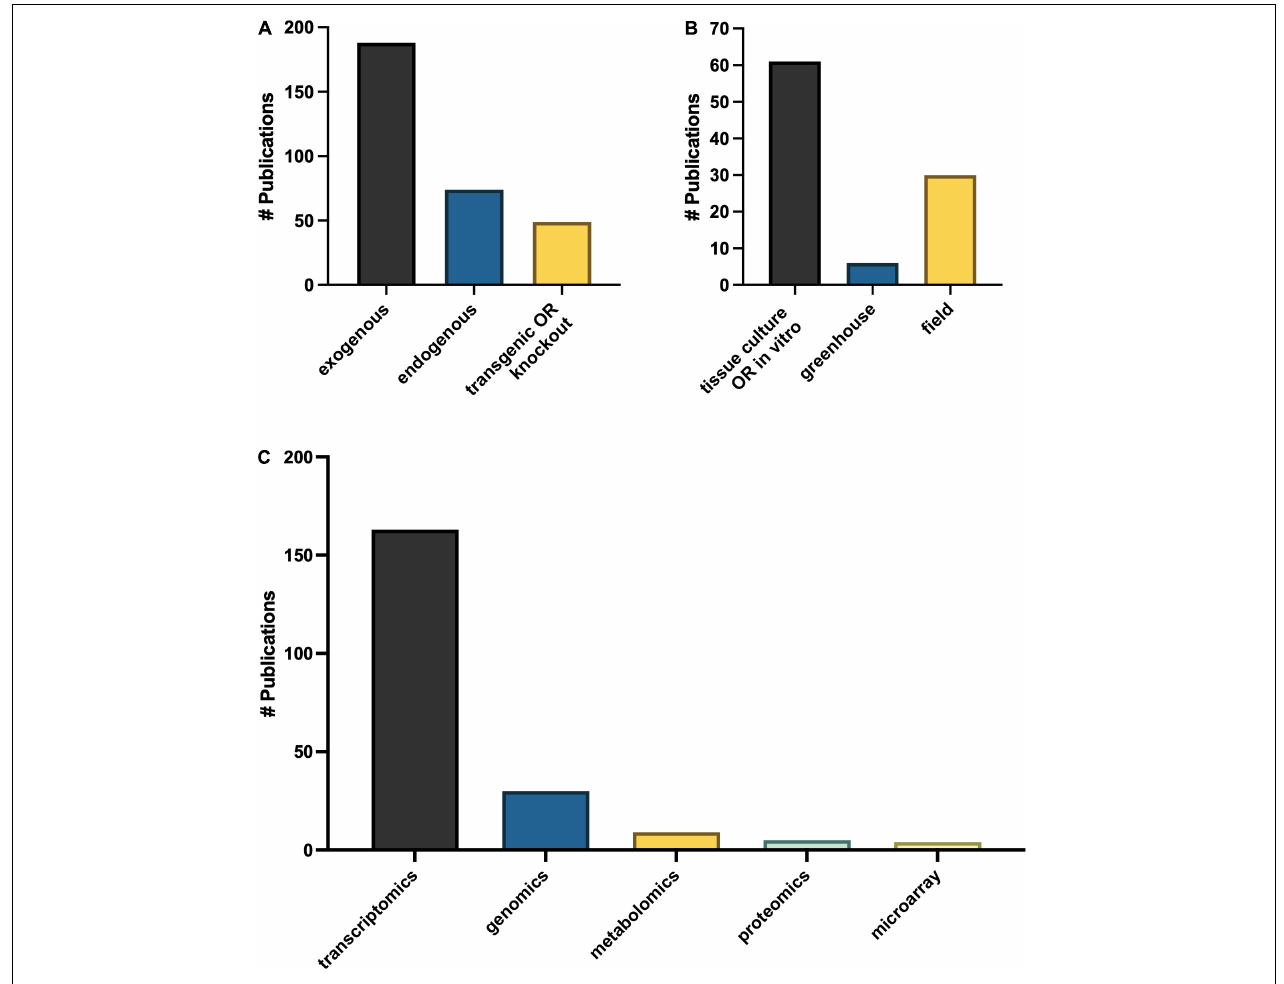
FIGURE 9 | Major themes in approaches to melatonin research in plants (A) growth methods, (B) melatonin treatment type and (C) OMICs